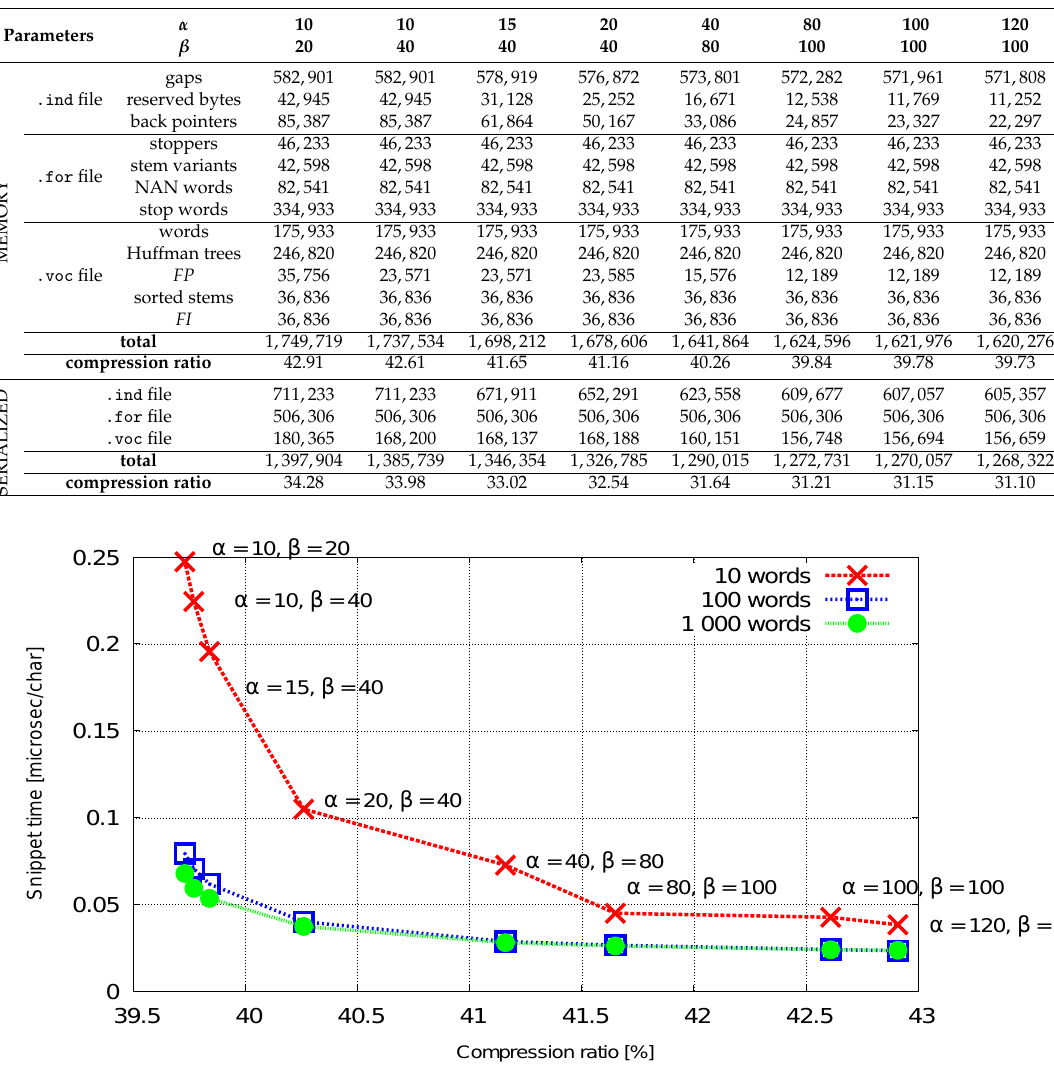
Figure 4. PISI : Compression ratio / Snippet time trade-off corresponding to different values of the parameters α and β . The time is stated in microseconds per character. Single curves represent different number of words that are decompressed to compose a